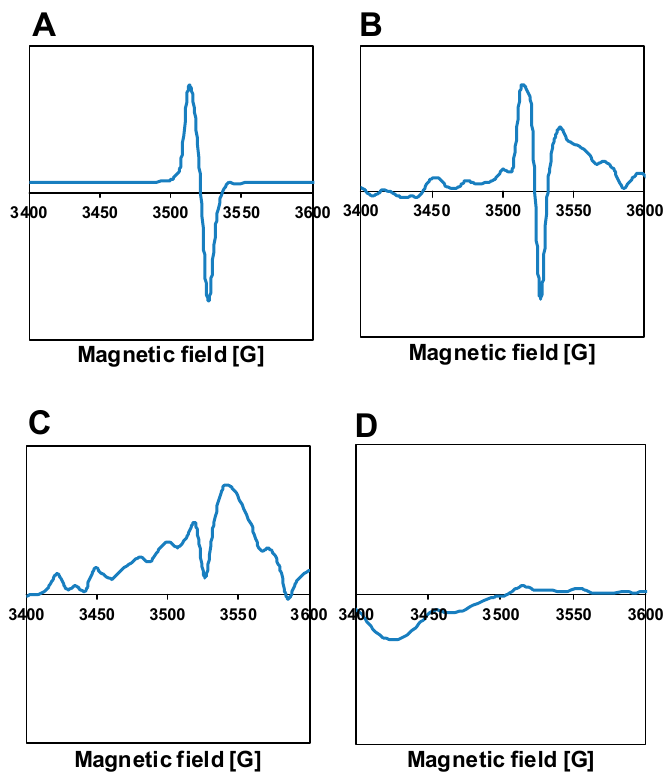
Figure 4. Electron spin resonance (ESR) spectra of the bare TiO 2 samples; ( A ) sol–gel-prepared, calcined at 400 °C (SG400); ( B) sol–gel-prepared, calcined at 450 °C (SG450); ( C ) sol–gel-prepared, calcined at 500 °C (SG500); ( D ) P25